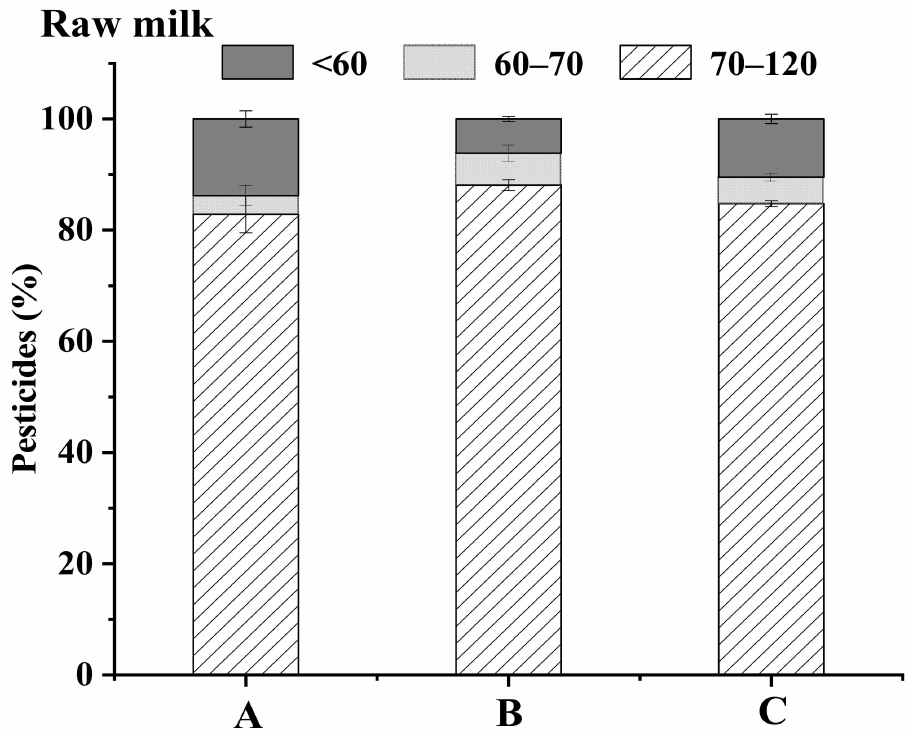
Figure 1. Recoveries (%) obtained for various salt pockets methods; ( A ) 4 g anhydrous MgSO 4 , 1 g sodium chloride, ( B ) 4 g anhydrous MgSO 4 , 1 g anhydrous NaCl, 1 g dihydrate trisodium citrate and 0.5 g disodium citrate, and ( C ) 6 g anhydrous MgSO 4 , 1.5 g sodium